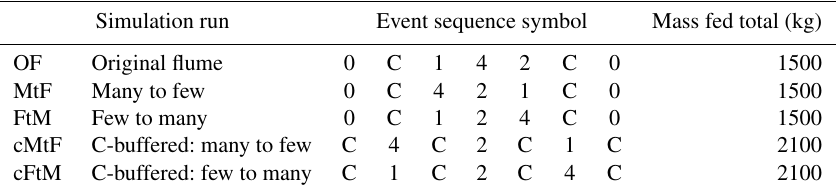
Table 2. Sequencing of events in runs that were simulated as permutations of the original flume experiment. Each of the seven periods was 40h long and each run lasted 280h in total. There was no sediment input during the no feed runs (0). Within all other period types, 300kg of sediment was fed over 40h, either constantly (C) or in pulses (one, two, or four events). Besides recreating the original flume sequence (OF), we simulated two runs where the pulsed events occur either in order from many pulses to few (MtF) or from few to many (FtM). To explore if the system could rebound from the impact of a certain pulse phase during a constant-feed phase, we created two additional runs where this was the case (cMtF and cFtM), which led to a 600kg higher total sediment